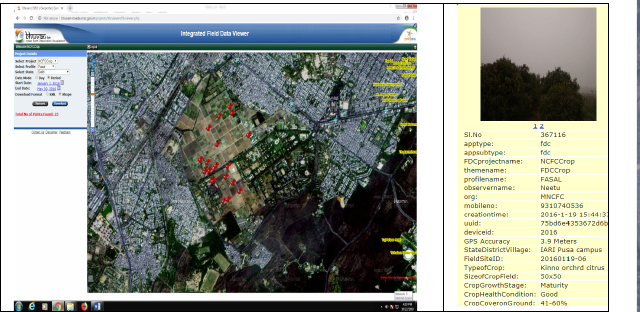
Figure 2. Ground Truth Data collected over the study area in